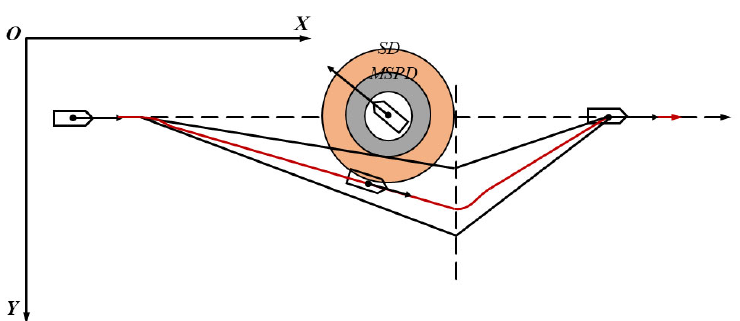
Figure 3. Illustration of the collision avoidance process of a ship at the machine ‐ aided level.